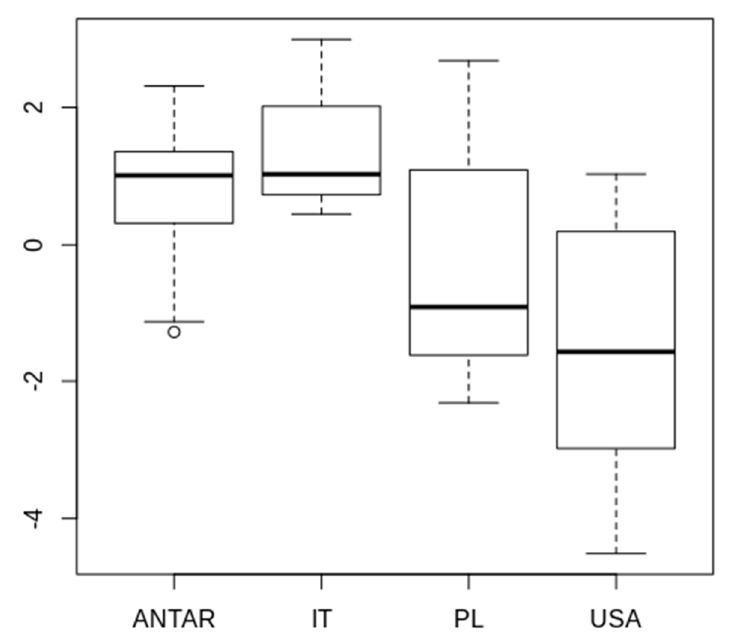
Figure 9. Differences between the studied populations of Paramacrobiotus fairbanksi Schill, Förster, Dandekar and Wolf [25] expressed by the first component of PCA performed on pt ratios of lengths of the measurements of chosen morphological structures (Antar, Antarctic; IT, Italy; PL, Poland; USA, USA). Minimum, maximum, median, first quartile, and third quartile for each population are presented.